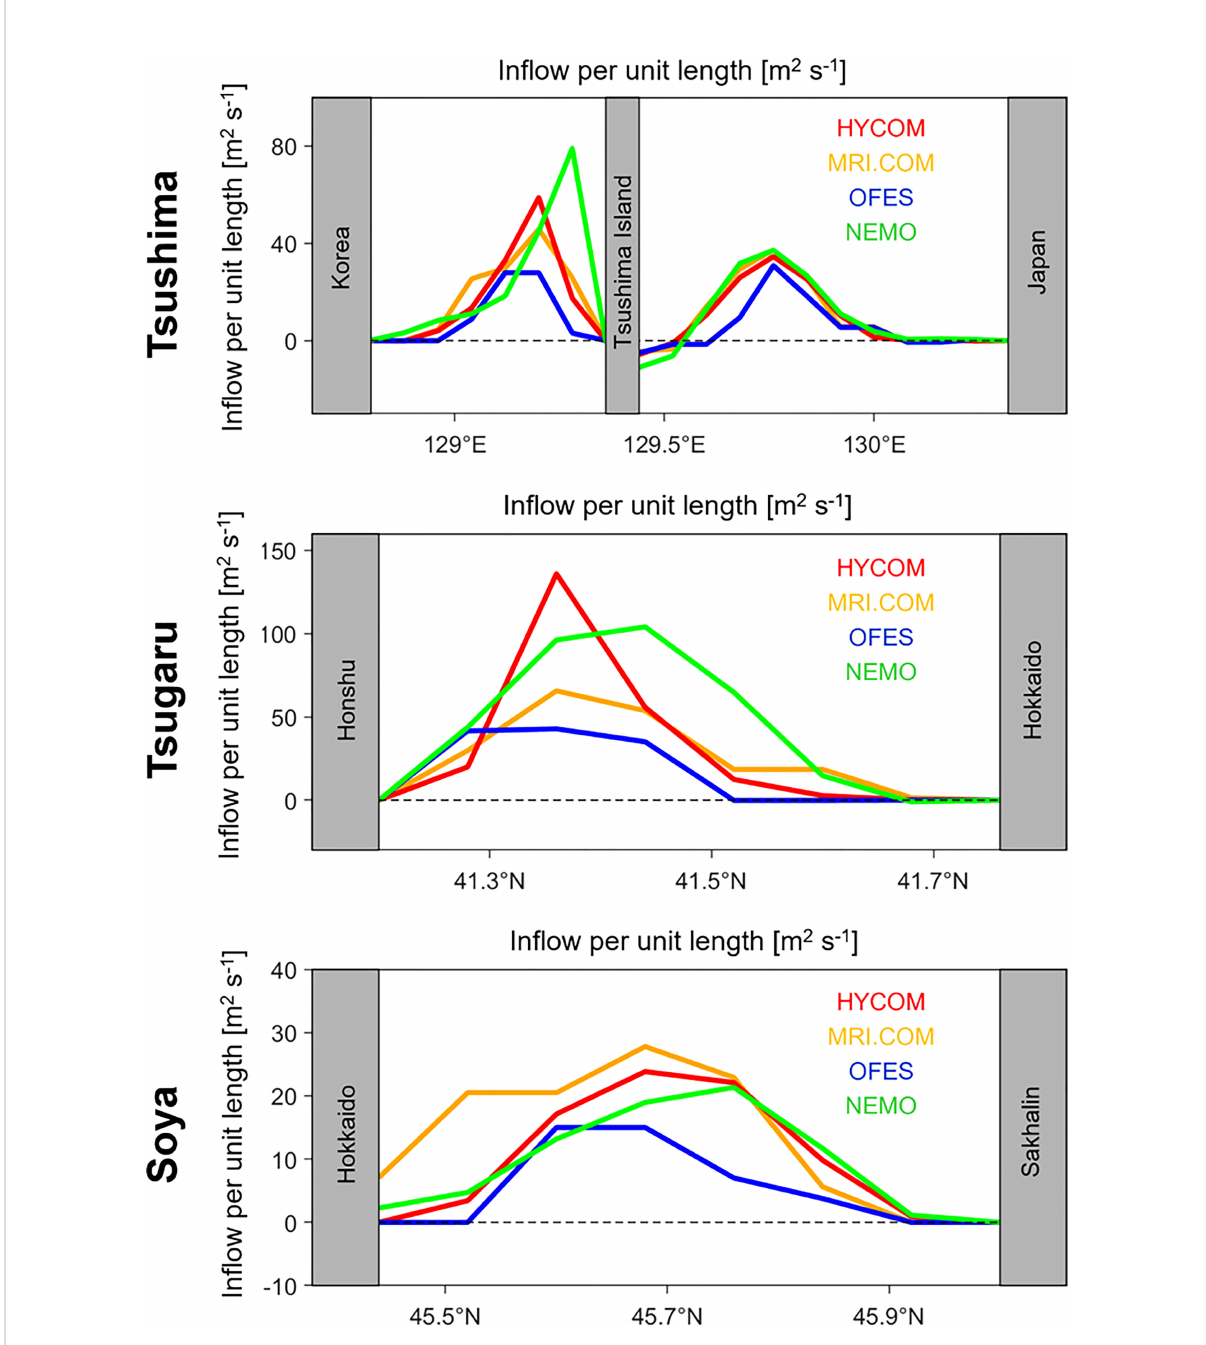
FIGURE 11 Depth-integrated velocities per unit length orthogonal across three major straits as simulated by the ocean models HYCOM (red), MRI.COM (orange), OFES (blue), and NEMO (green) for the time period from 1993 to